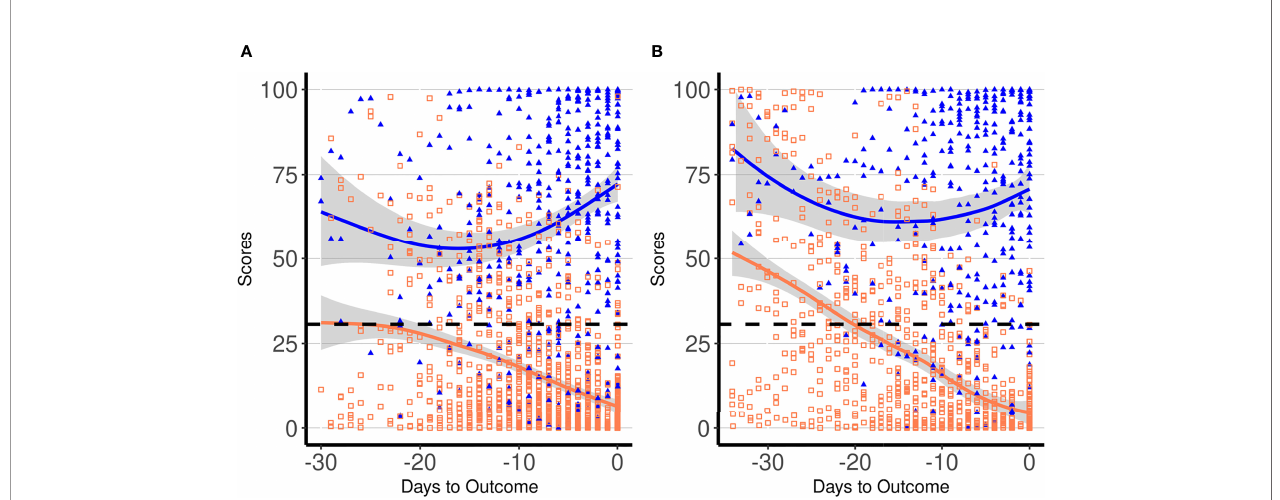
FIGURE 2 | Dynamic pro fi les of proposed laboratory score in COVID-19 patients according to days to the outcome in the derivation (A) and in the validation cohort (B) . Symbols indicate single patients ’ daily score in survivors (empty orange squares) and non-survivors (solid blue triangles), respectively. Blue and orange lines represent trajectories of daily average score values in non-survivors and survivors, respectively, with the 95% con fi dence intervals displayed by the shaded area. The dashed line indicates the best cutoff for score